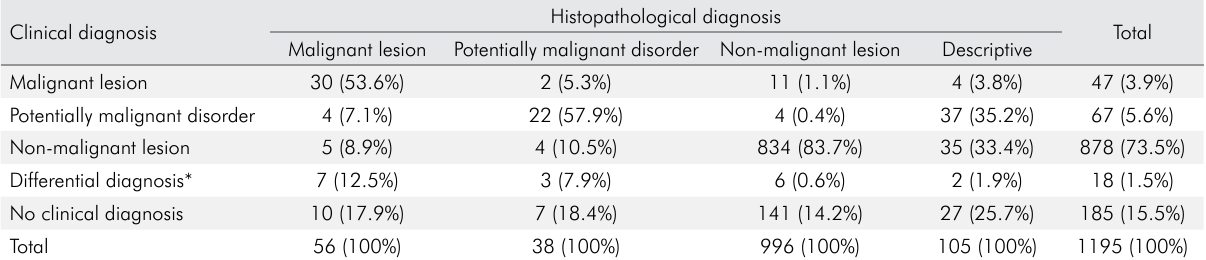
Table 3. Distribution of all cases (n = 1195) between clinical and histopathological diagnosis according to malignancy. Clinical diagnosis